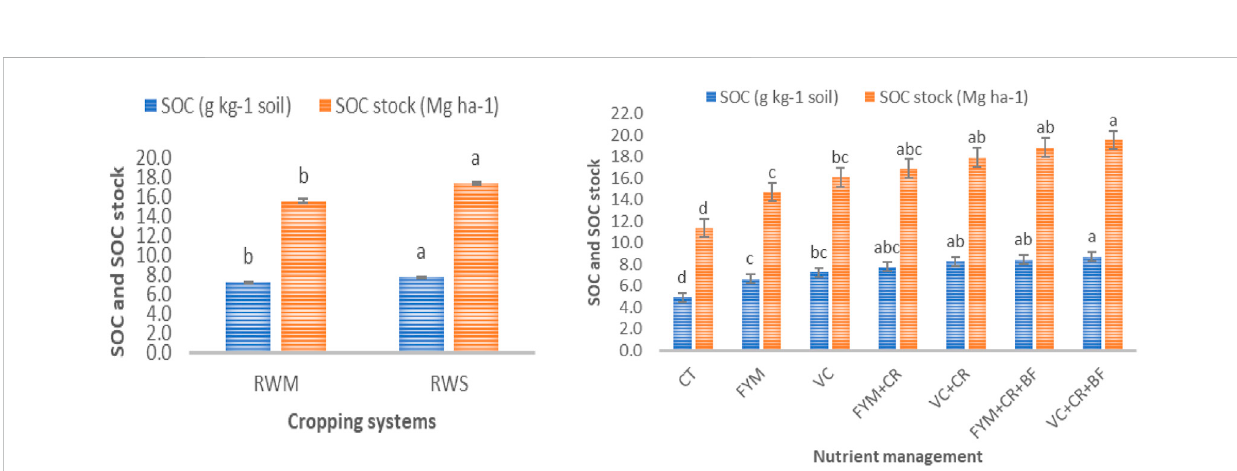
FIGURE 7 Long-term effect of cropping systems and organic nutrient management on SOC and SOC stock. SOC: soil organic carbon; RWM: rice-wheat- mung bean; RWS: rice-wheat-sesbania; CT: control; FYM: farm yard manure; VC: vermicompost; CR: crop residue(s); and BF: biofertilizer(s). Statistical method: analysis of variance for strip-plot design in SAS 9.3 software; n = 42. Values with a different capital letter indicate a signi fi cant difference among the different treatments at p < 0.05 by the LSD test. Bars represent means ±